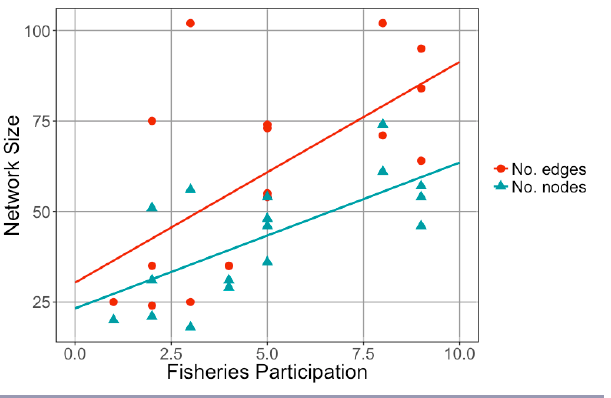
Fig. 4 . Number of fisheries in which an individual participates (past and present) is a significant predictor of individual network